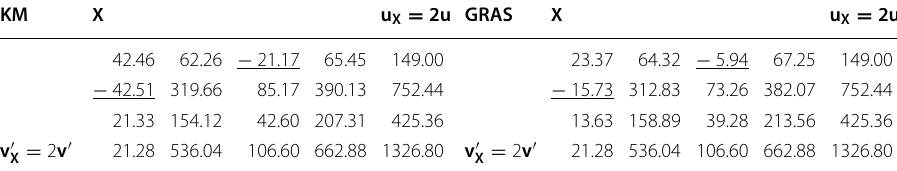
With the same location of underlined matrix elements as in Table 10